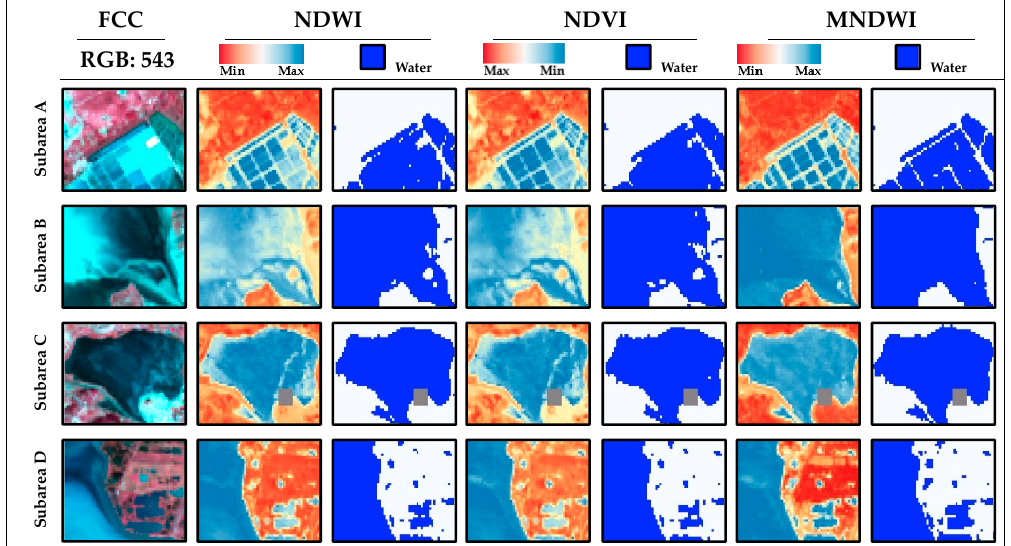
Figure 4. The false-color composite (FCC) maps (date: 10–23-2018) and resulting spectral indices of sub-areas (A, B, C and D).